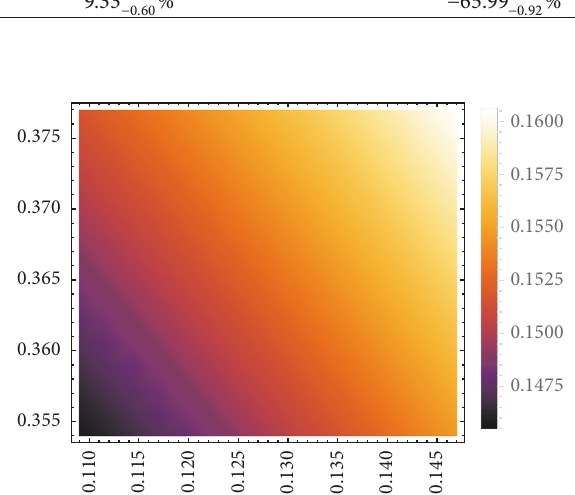
Figure 1: The direct 𝐶𝑃 violation as a function of 𝜌 and 𝜂 from the CKM matrix element with isospin symmetry breaking for the decay process of 𝐵 𝑠 󳨀→ 𝜋 0 𝜂 . The horizontal axis and vertical axis refer to the values of 𝜌 and 𝜂 ,